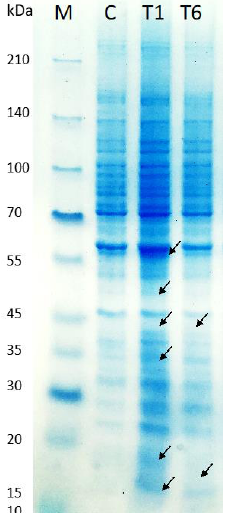
Figure 6. SDS-PAGE study of Salmonella enterica subsp. enterica ATCC51741 whole cell proteins after peptide-based formulation treatment. Legend: C: Salmonella untreated; T1: CFSCys5-4/CFSGt28:1:1 (v/v); T6: PPCys5-4/PPGt28:1:1 (v/v). M: molecular marker (Takara, Clearly Protein Ladder); arrows indicate different bands.